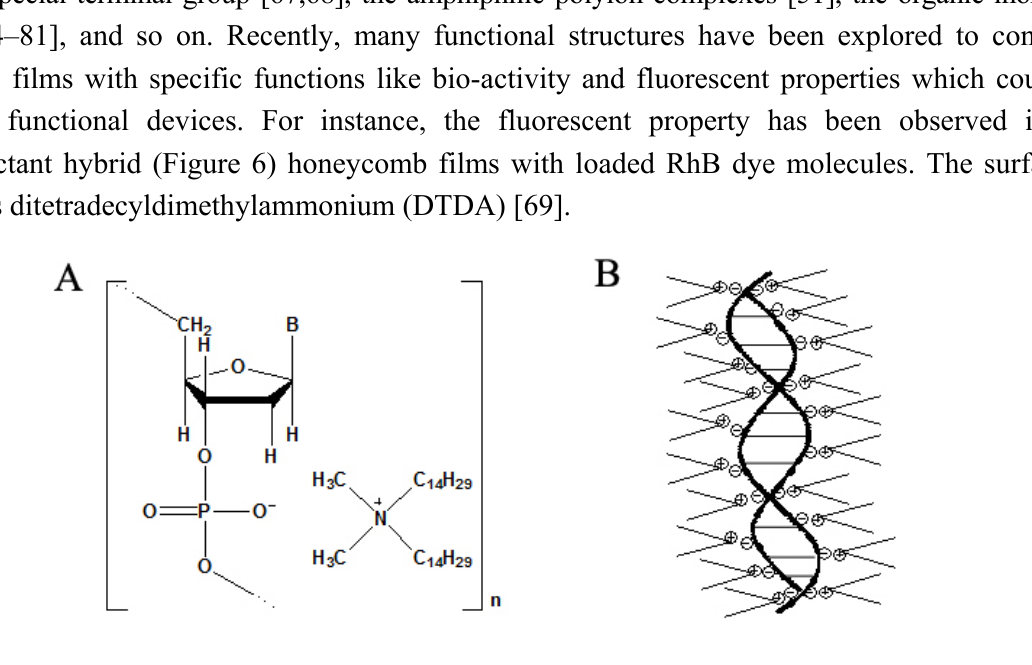
Figure 6. The chemical structure ( A ) and the schematic view ( B ) of the DNA-DTDA hybrid, with copyright permission from